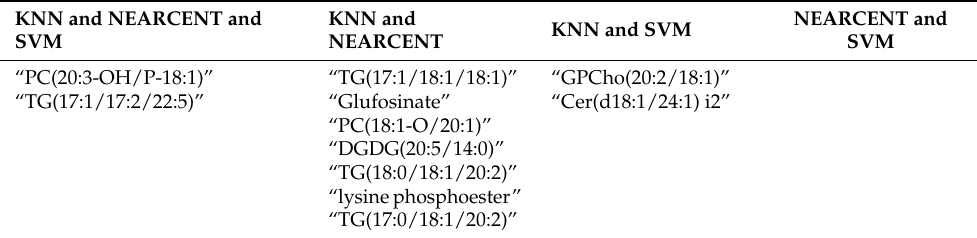
Figure 14. Models using forward selection methodology, with the T2DM-DN dataset. The solid black line represents the most compact and accurate model. The vertical axis shows the classification accuracy. The horizontal axis represents the ordered features, each of which corresponds to a number. Table 11. Common metabolites found in each model for